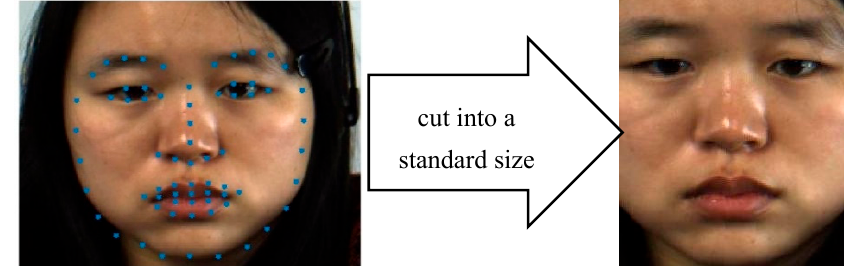
Figure 3. Landmarks on the face (68 total) and cut the image.